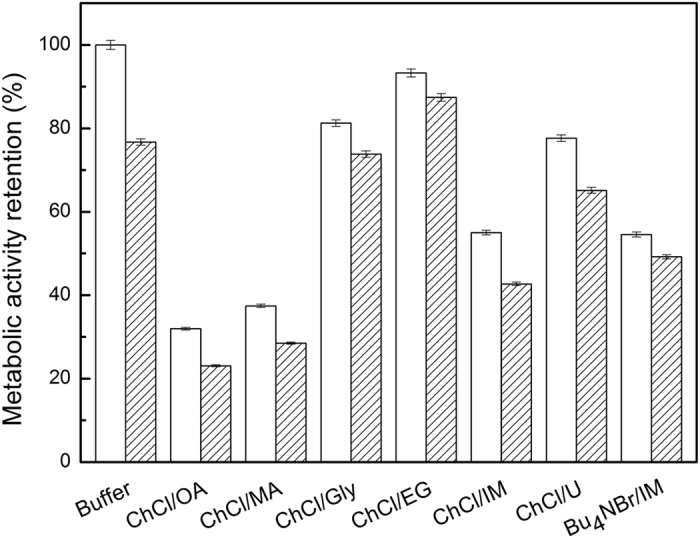
The sugar metabolism activity retention of Acetobacter pasteurianus GIM1.158 cells in various DES -containing co-solvent systems without (white) and with (pattern) substrate.